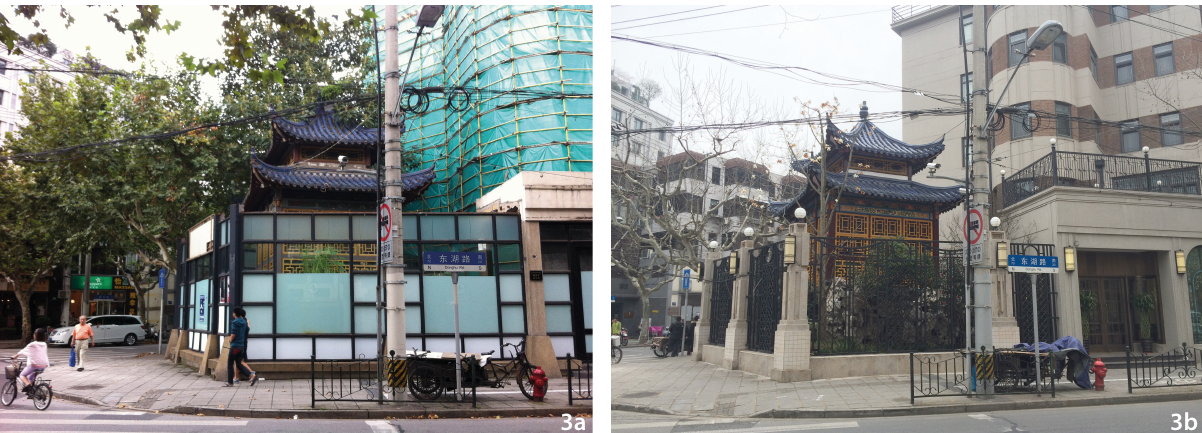
Figure 3a and 3b Shanghai, People’s Republic of China. The temple in Donghu Road. 3a: the temple was previously located inside a restaurant, September 2014. 3b: the temple has been isolated as monument, in a clear process of Westernisation, March 2016. (Source: the author).